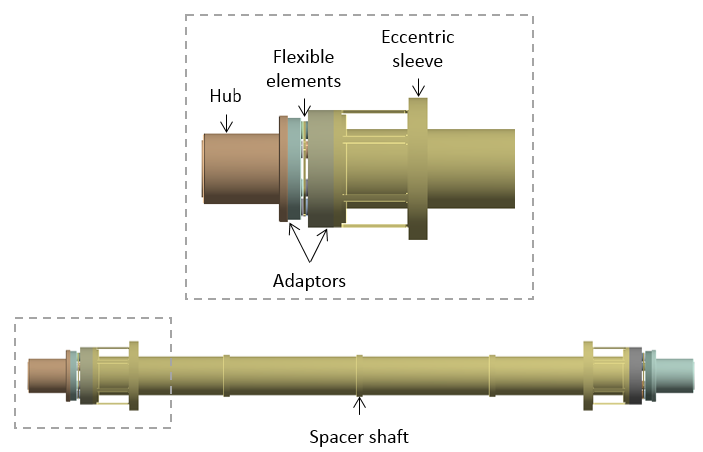
Figure 2. Test shaft and eccentric sleeve.